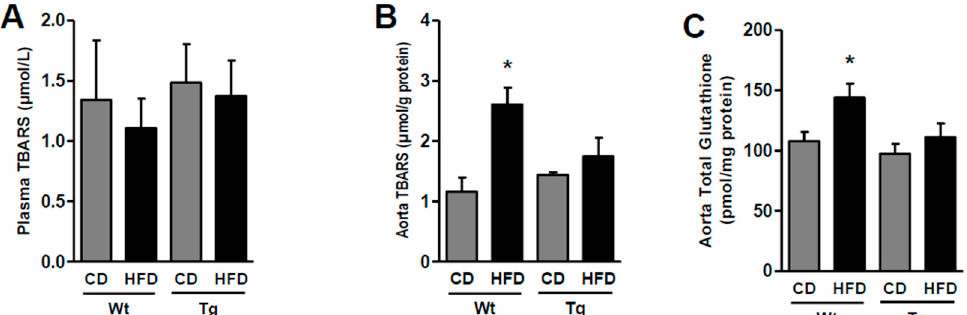
Figure 3. Systemic and vascular oxidative stress and antioxidant potential. Quantitative analysis of plasma ( A ) and aortic ( B ) thiobarbituric acid reactive substances (TBARS) and tissue total glutathione ( C ) in control (Wt) and transgenic (Tg) mice fed the control diet (CD) or the high-fat diet (HFD). The data represent seven mice per group. * p < 0.05 vs. other groups.